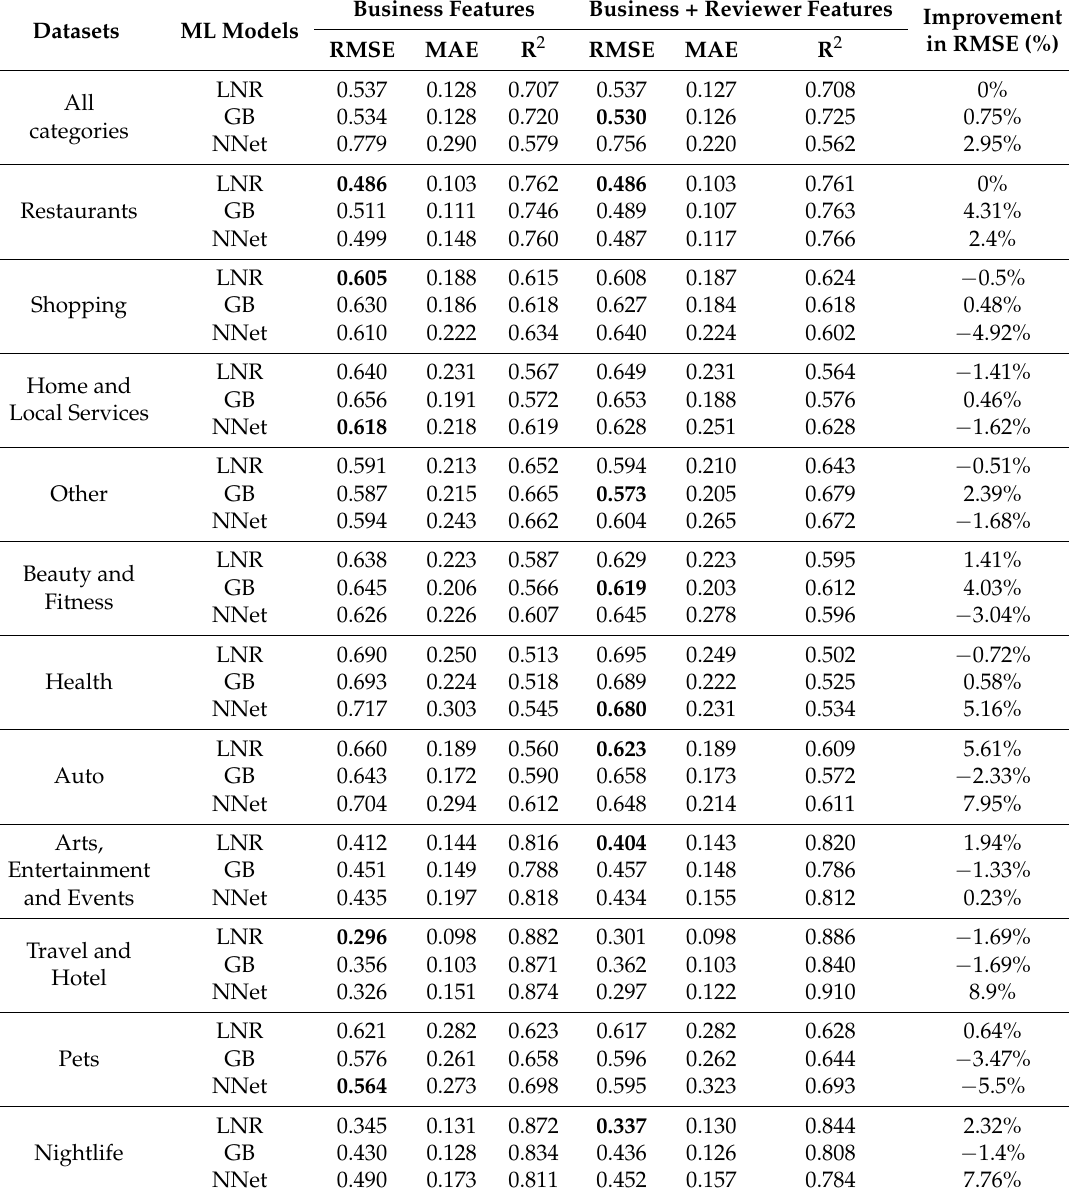
Table 6. Evaluation results, performance comparisons and impact of reviewer features on